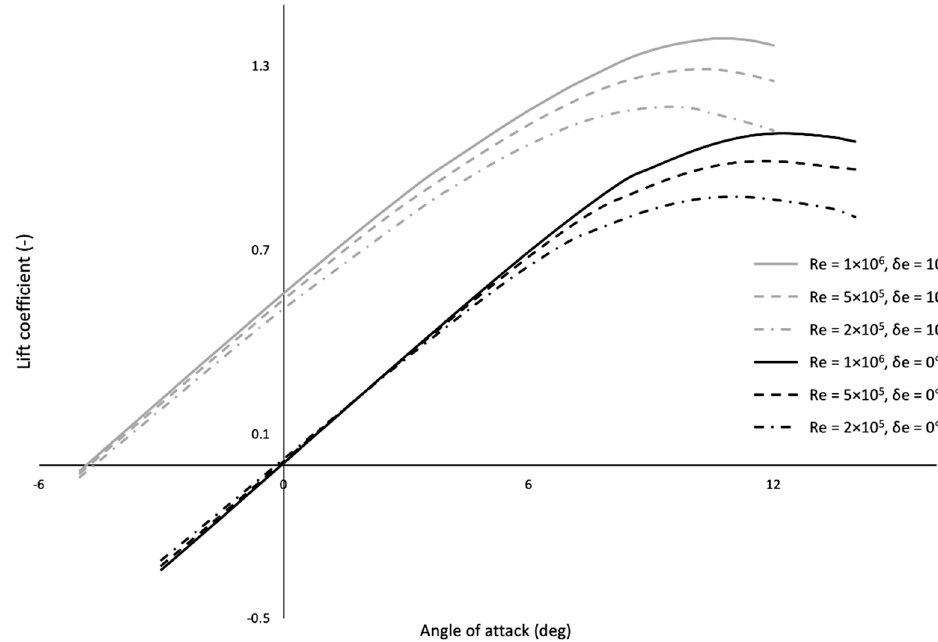
Figure 7. Lift coefficient as a function of angle of attack graph, for the MH-93 airfoil for three different Reynolds numbers ( Re ), with and without elevon deflection ( δ e ).